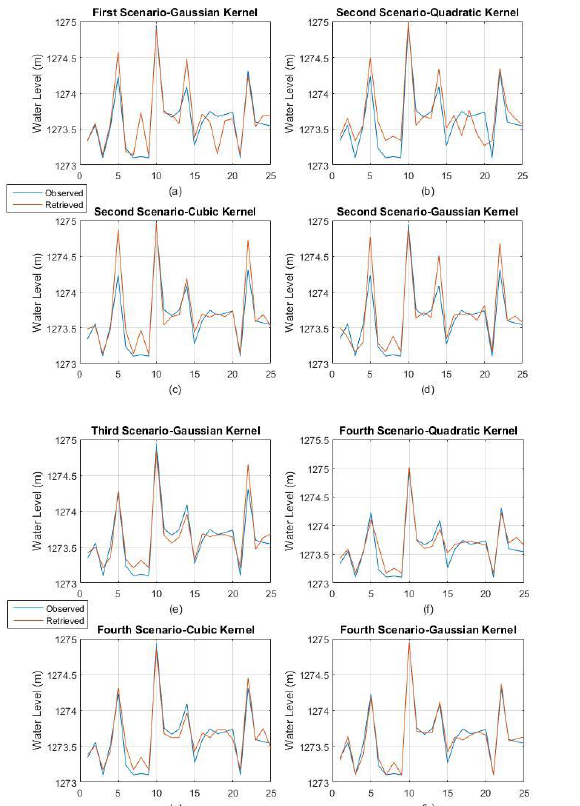
Figure 9. Comparisons of retrieved and observed water